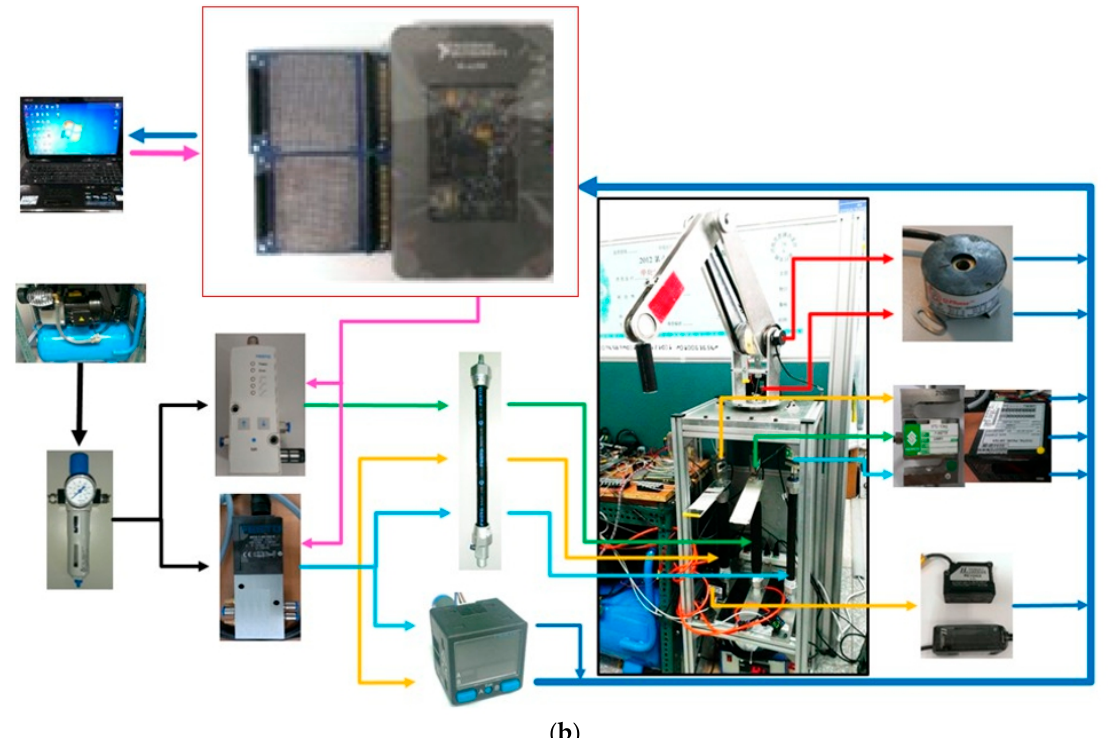
Figure 3. ( a ) Transmission sketch of a robot arm, ( b ) experimental